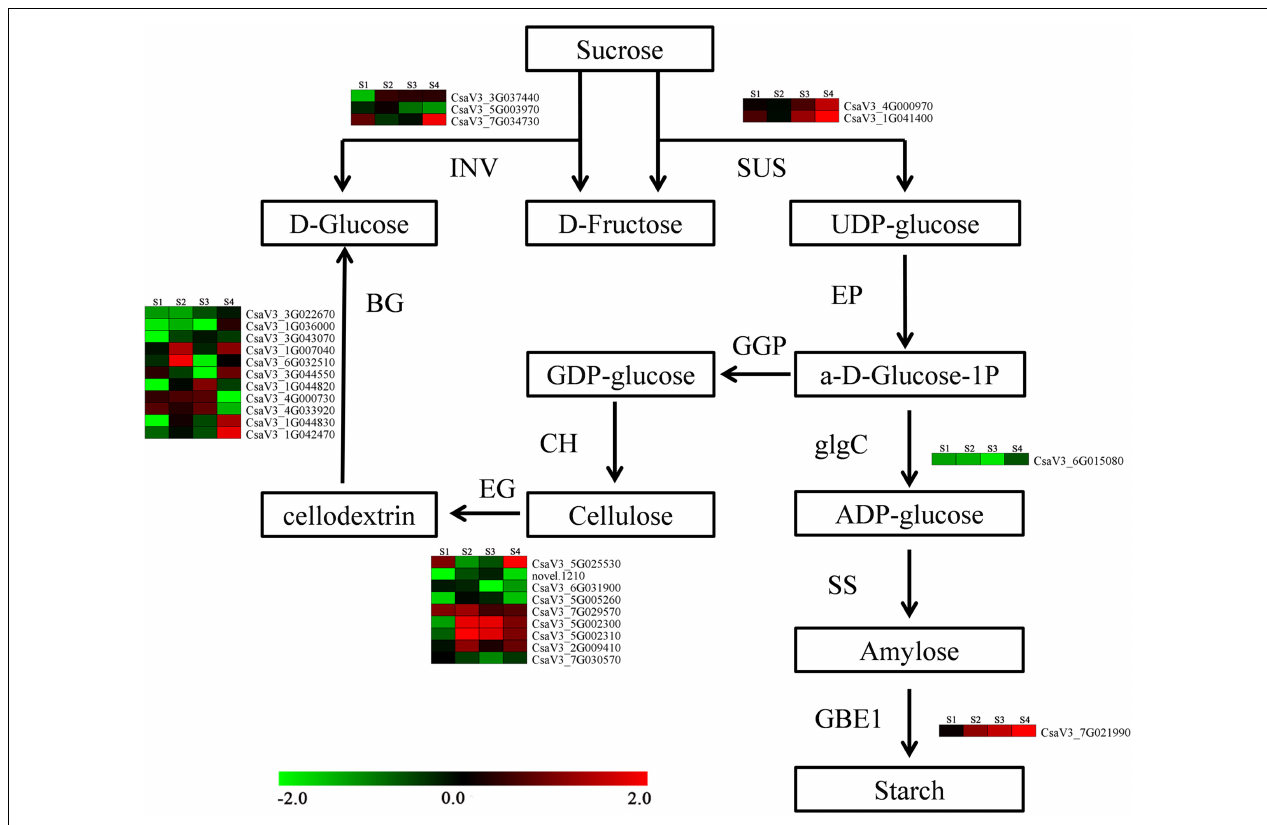
FIGURE 6 | Predicted carbohydrate metabolism pathways in different anther development under HS. INV: invertase; SUS: sucrose synthase; EP: ectonucleotide pyrophosphatase; glgC: glucose-1-phosphate adenylyltransferase; SS: starch synthase; GBE1: glucan branching enzyme; CH: cellulose synthase; EG: endoglucanase; BG: